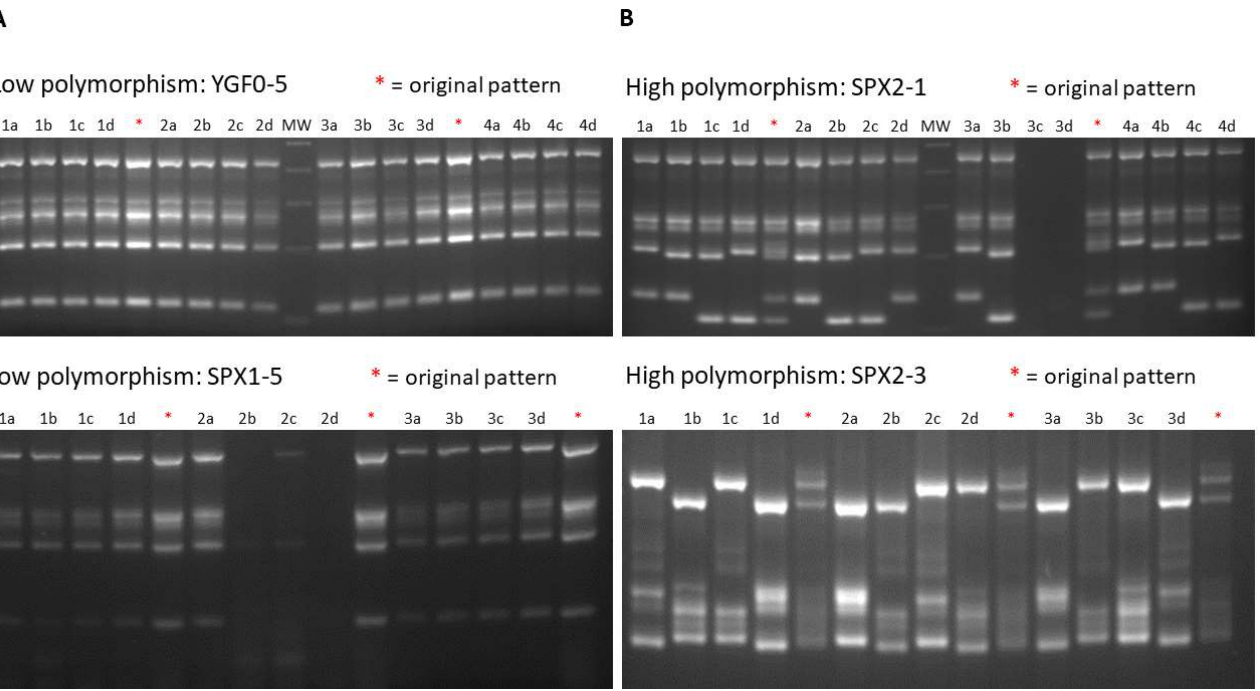
Figure 4. Patterns generated by four viable spores (a, b, c and d) per asci of strains with simple ( A ) and complex ( B ) microsatellite patterns. Microsatellite patterns of spores and their parental strains (red asterisk) of complex pattern (upper panels) and simple pattern (lower panels) strains. The microsatellite pattern of both parental complex strains segregated between the spores, resulting in the generation of simple pattern strains. Microsatellite pattern of spores from simple pattern strains remain the same comparing with the diploid, suggesting a higher genome homogeneity. MW = DNA size marker.